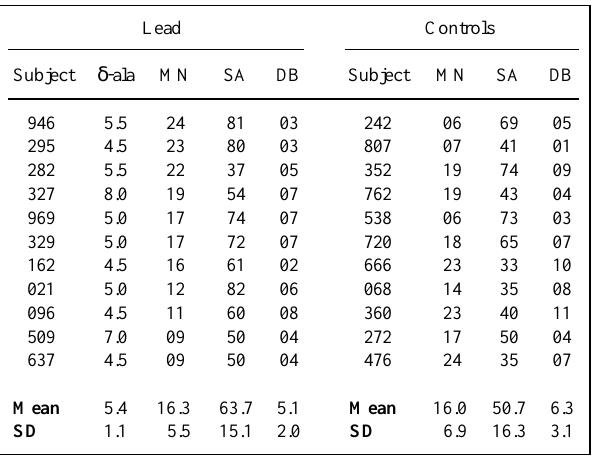
Table V - Frequency of binucleated cells with micronuclei (MN) and other nuclear anomalies in 2000 cells analyzed per hospital worker potentially exposed to ethylene oxide, and their respective controls.